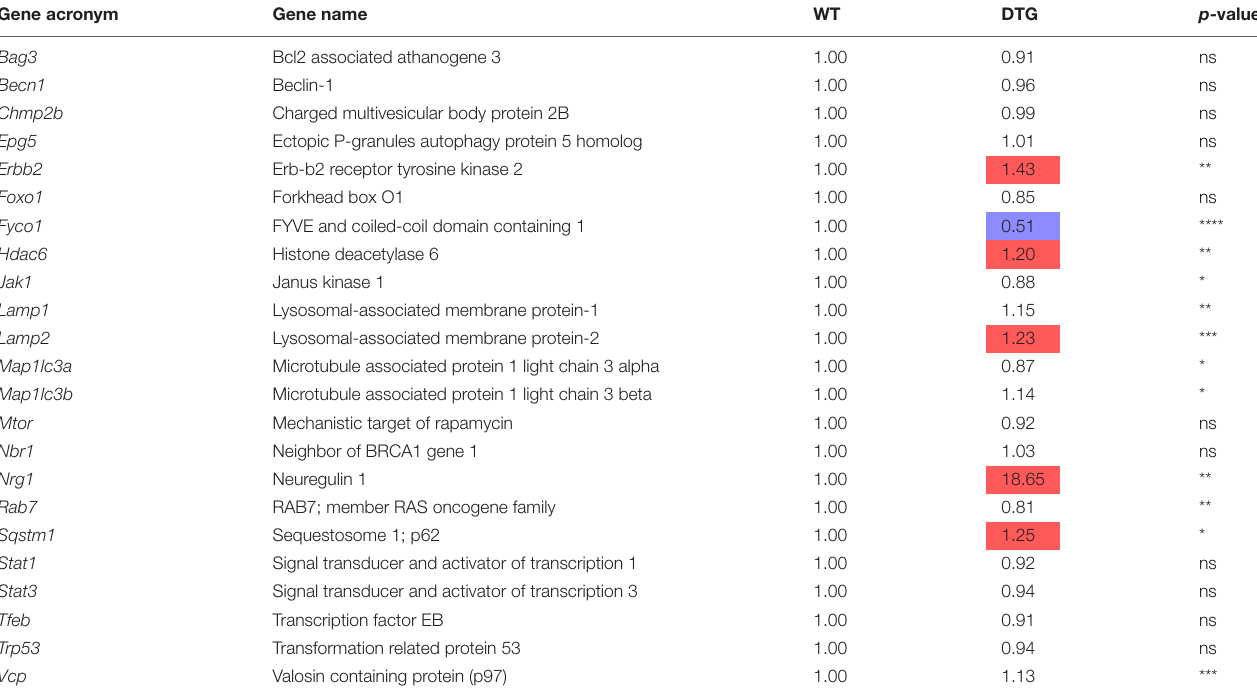
TABLE 2 | Autophagy-lysosomal pathway gene expression analysis in DTG and WT mice. Gene